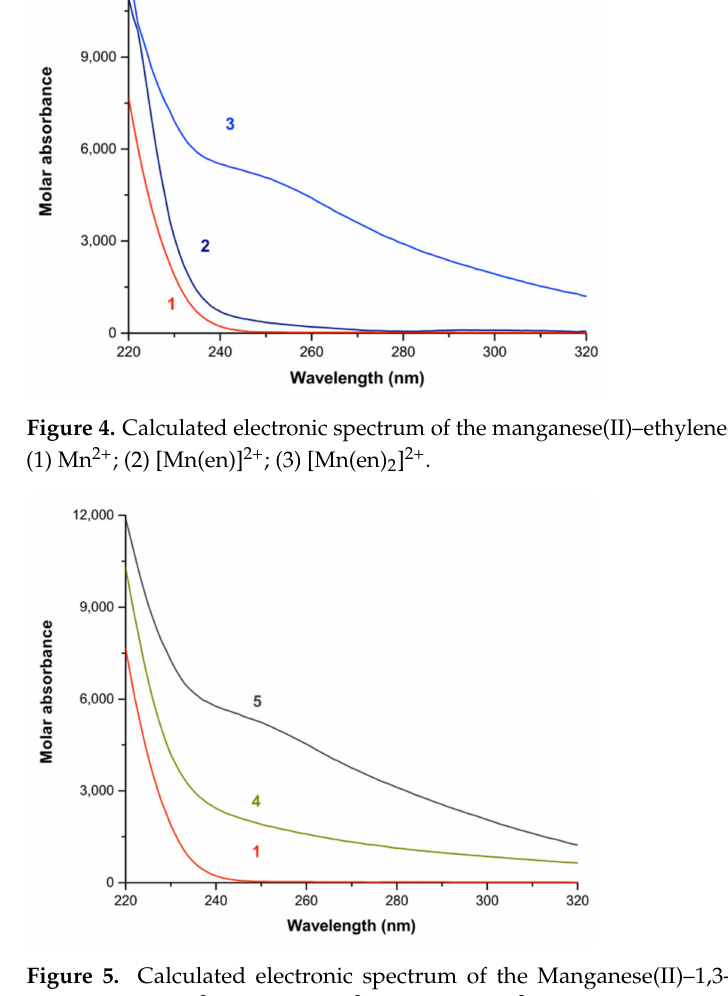
Figure 5. Calculated electronic spectrum of the Manganese(II)–1,3-propanediamine species in methanol: (1) Mn 2+ ; (4) [Mn(pn)] 2+ ; (5) [Mn(pn) 2 ] 2+